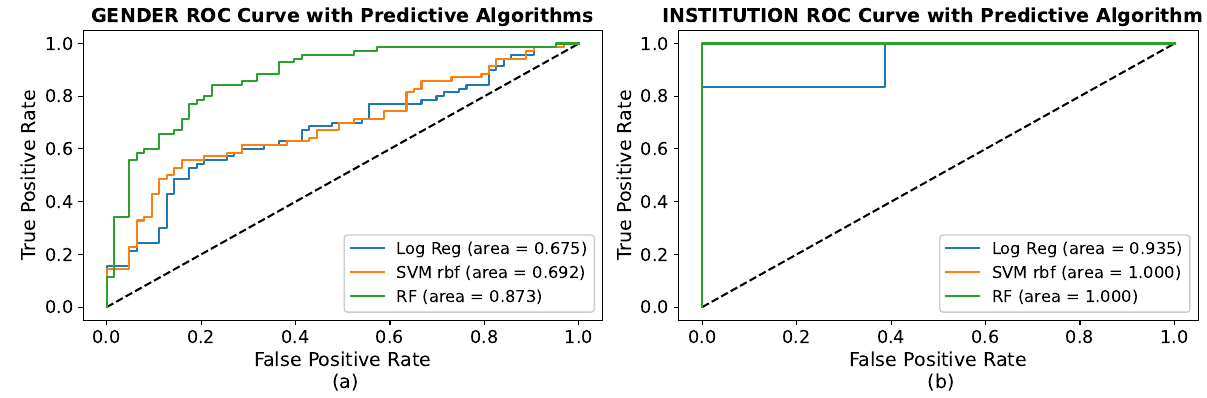
Figure 10. ROC analysis of: ( a ) Gender Identification; ( b ) Institution Identification. Figure 11 compares the performance metrics of applied algorithms for student’s gender prediction. The blue bins represent the performance of classifiers (LR, RF, and R-SVM) before applying GB feature selection. The green bins reflect the performance of classifiers after applying the GB algorithm. It can be seen that GB does not impact the accuracy of RF but enhances the accuracies of LR and R-SVM by 1%. The highest gender prediction accuracy of 98% has been attained with the help of GB incorporating an RF classifier, which is also a significant improvement in the previous research [32]. Our gender predictive model enhanced the accuracy by 8.6%. Furthermore, each classifier’s MCC, Precision, and F-score have also been improved with the GB feature selection approach for the gender prediction